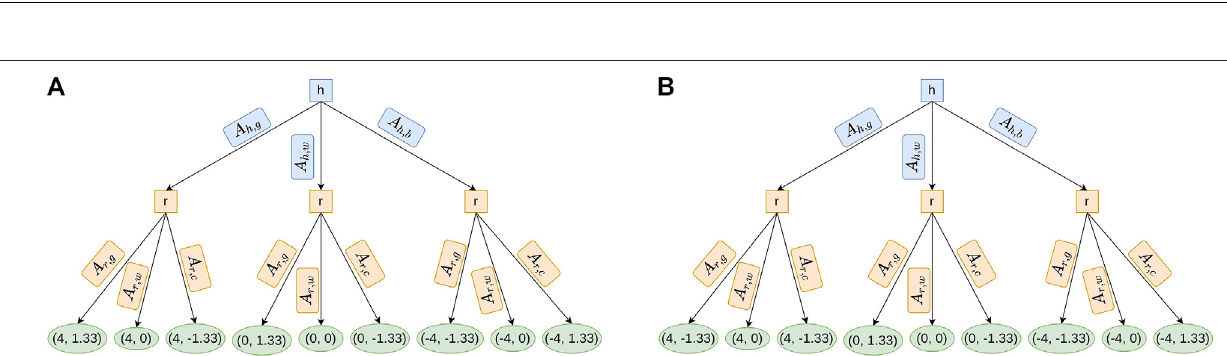
FIGURE 3 | Example of the solving steps of the puzzle two by a participant and Nao. (A) The human puts a cube in a wrong position. (B) Nao asks him to remove thatcube. (C) Thehumanputs acubeinacorrectposition,then therobotdoes nothing. (D) Thehumanputs another cubeinacorrectpositionand thepuzzle issolved.